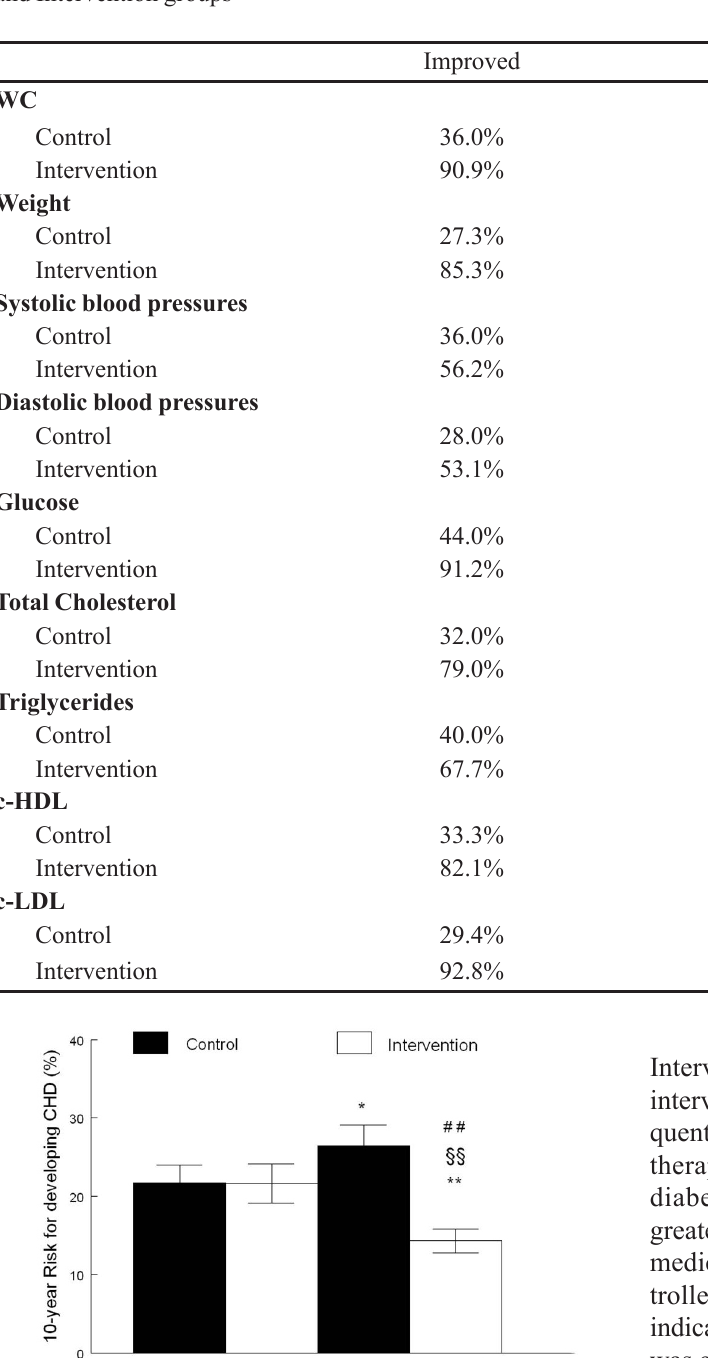
TABLE IV - Frequency distribution of changes in anthropometric and biochemical parameters and blood pressure of the Control and Intervention